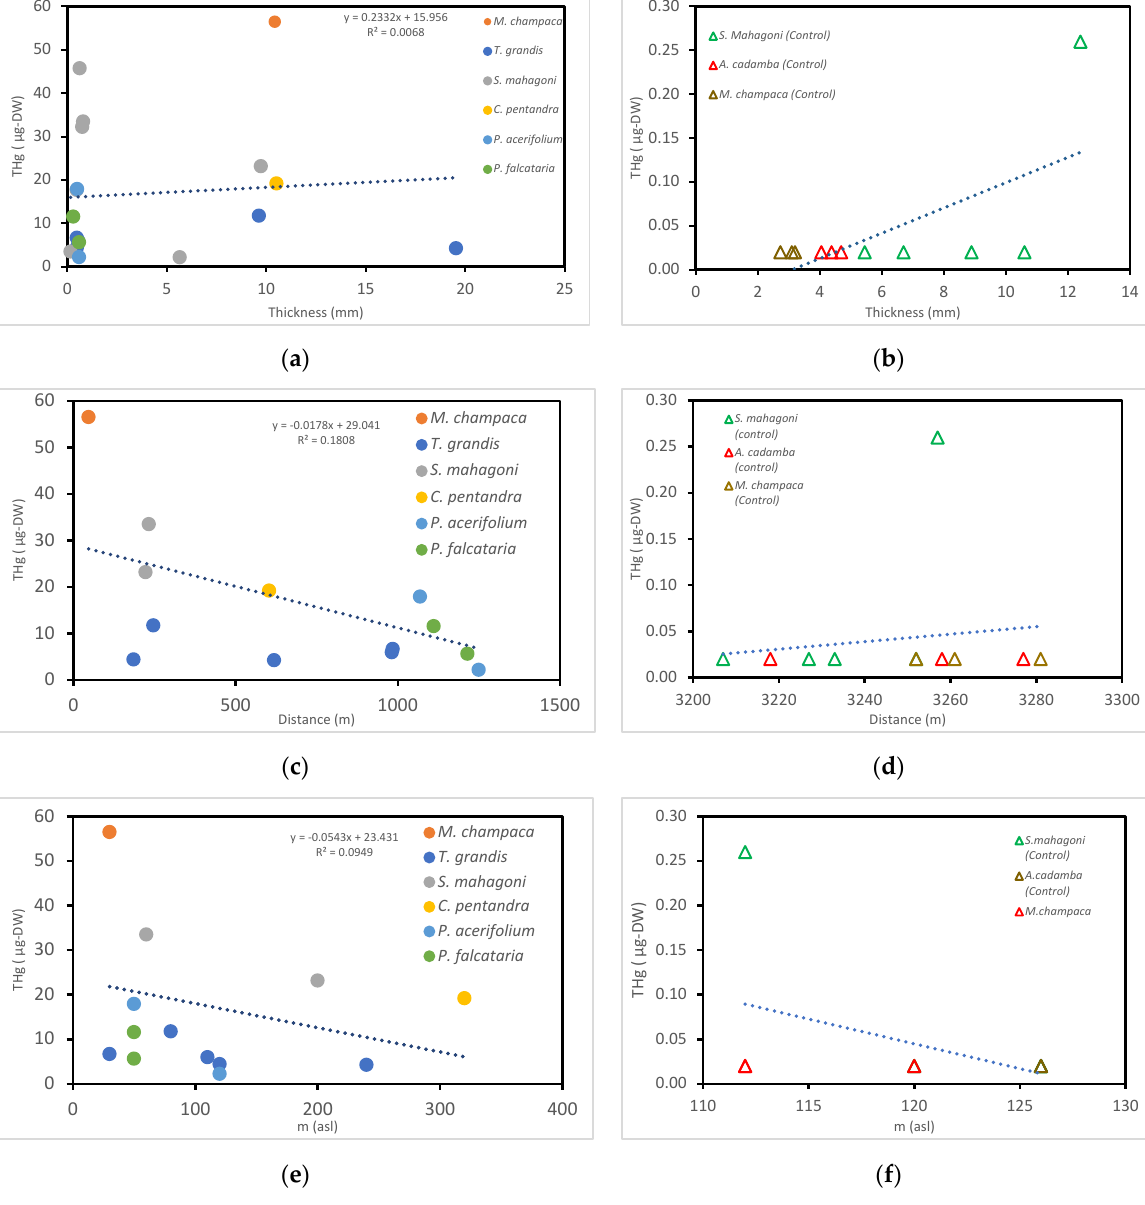
Figure 5. ( a ) Bark thickness (mm) versus THg found, ( b ) bark thickness versus THg found (control), ( c ) distance from ASGM (m) versus THg found, ( d ) distance from ASGM (m) versus THg found (control), ( e ) elevation versus THg found, and ( f ) elevation versus THg found (control).